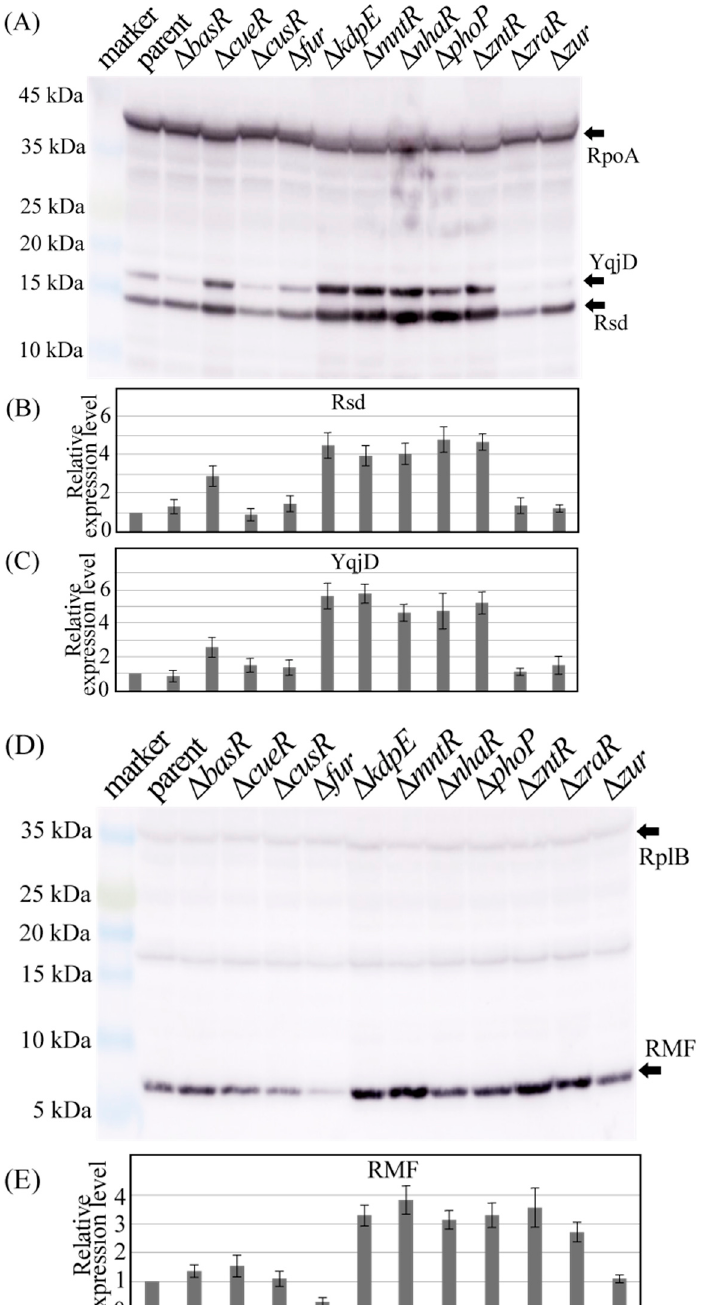
Figure 5. Protein levels of Rsd and RMF in each strain. The parental strain (parent) was harvested along with every mutant strain lacking the transcription factor gene 24 h after inoculation, and the cell extracts were analyzed using Western blotting. ( A ) Image of blotting membrane used for detecting Rsd and YqjD; RpoA was used as a reference. ( B , C ) Relative expression levels of Rsd and YqjD, respectively. The Rsd and YqjD band concentrations were divided by those of RpoA, and the values for each mutant were normalized against the value of their corresponding parent. ( D ) Western blot image of RMF; RplB was used as a reference. ( E ) Relative expression levels of RMF. The concentrations of RMF bands were divided by those of RplB, and the values for each mutant were normalized against the value of their corresponding parent. The images in ( A , D ) are representative, and the error bars in ( B , C , E ) are the probable errors calculated from three